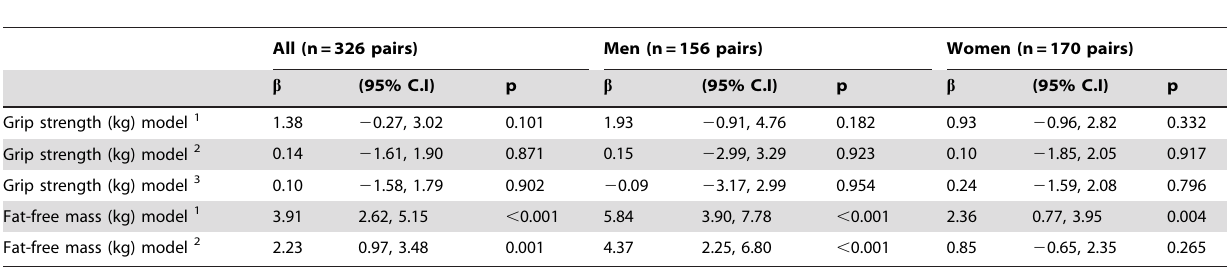
Table 3. Associations ( b –coefficients; 95% CI) between within-twin pair difference in birth weight (kg) and the within-twin pair difference in adult hand grip strength or fat free